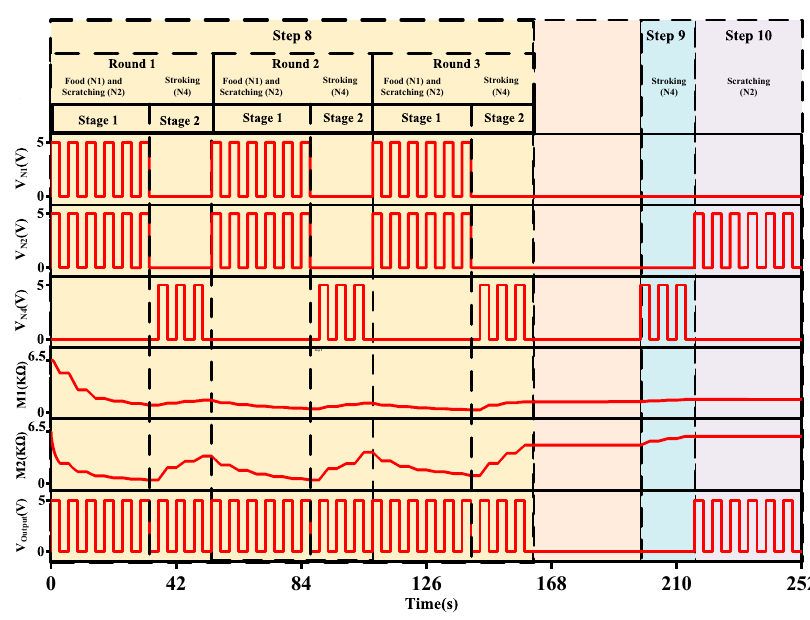
Figure 11. The transient response of Step 8 to Step 10.